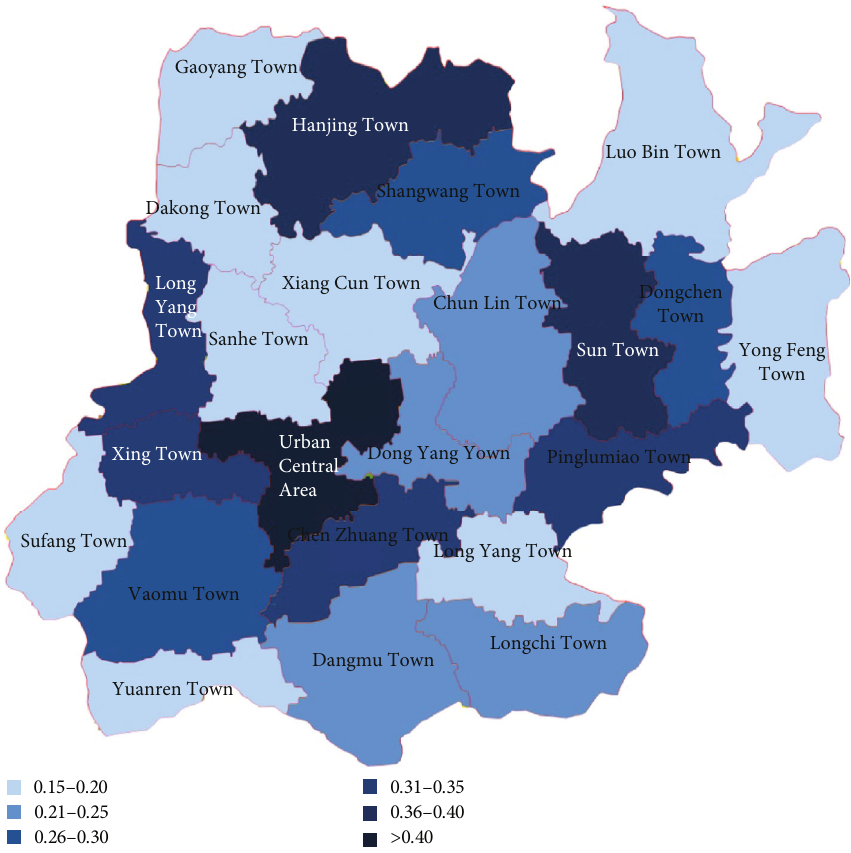
Figure 3: A map of urban and rural construction land development type in